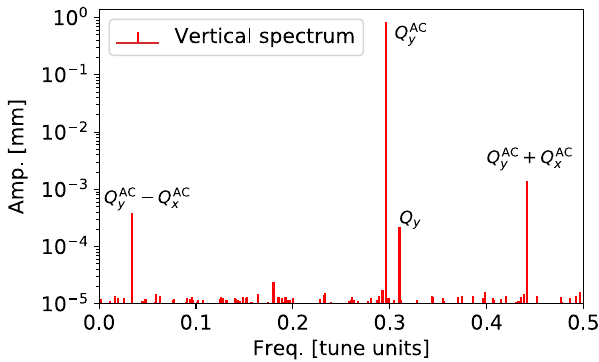
FIG. 3. Spectrum of the flattop turn-by-turn data. The main spectral line is measured at the ac dipole vertical tune Q ac y ¼ 0 . 296 and with an amplitude of A 0 ¼ 0 . 80 mm, i.e. A ¼ 2 A 0